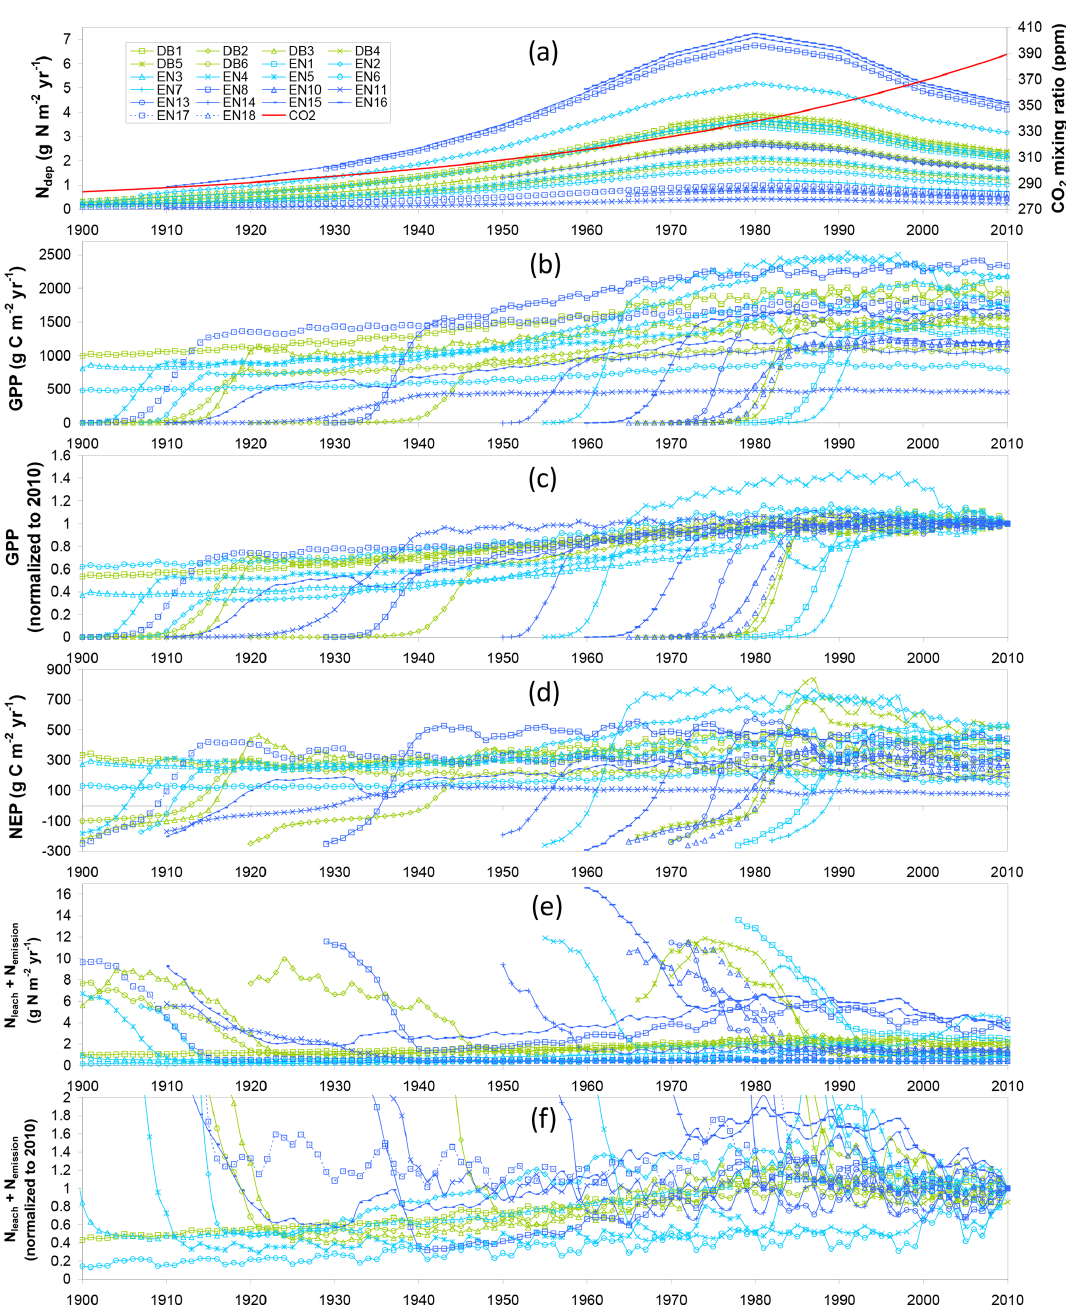
Figure 1. Time courses for 22 forest study sites (DB: deciduous broadleaf; EN: evergreen needleleaf) of (a) assumed atmospheric N r deposition ( N dep ) and CO 2 mixing ratio; and baseline model simulations of (b) gross primary productivity (GPP), (c) GPP normalized to the 2010 value, (d) net ecosystem productivity (NEP), (e) total N losses by leaching ( N leach ) and gaseous emissions ( N emission ), and (f) total N losses normalized to